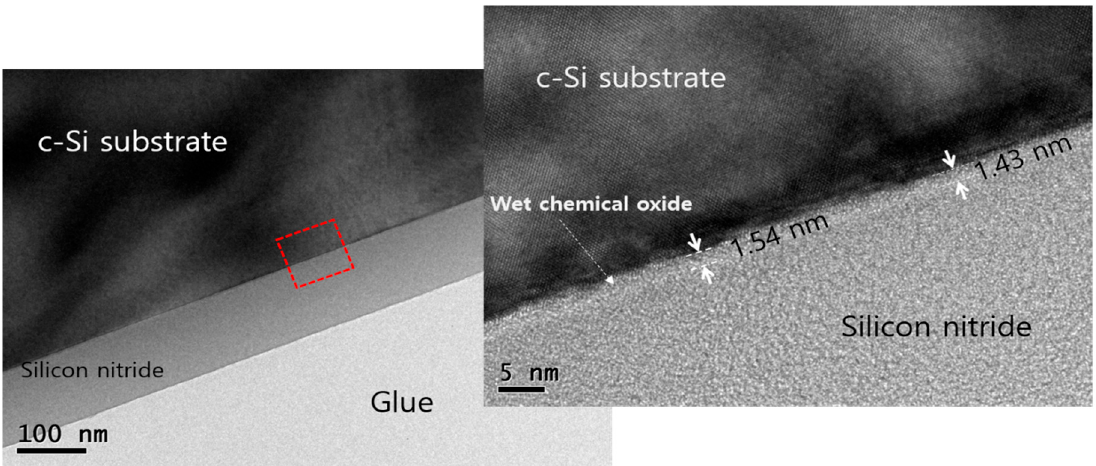
Figure 2. Transmission electron microscopy (TEM) images of the wet chemical oxide (SiO x-HNO3 ) layer in an SiN x / SiO x / Si